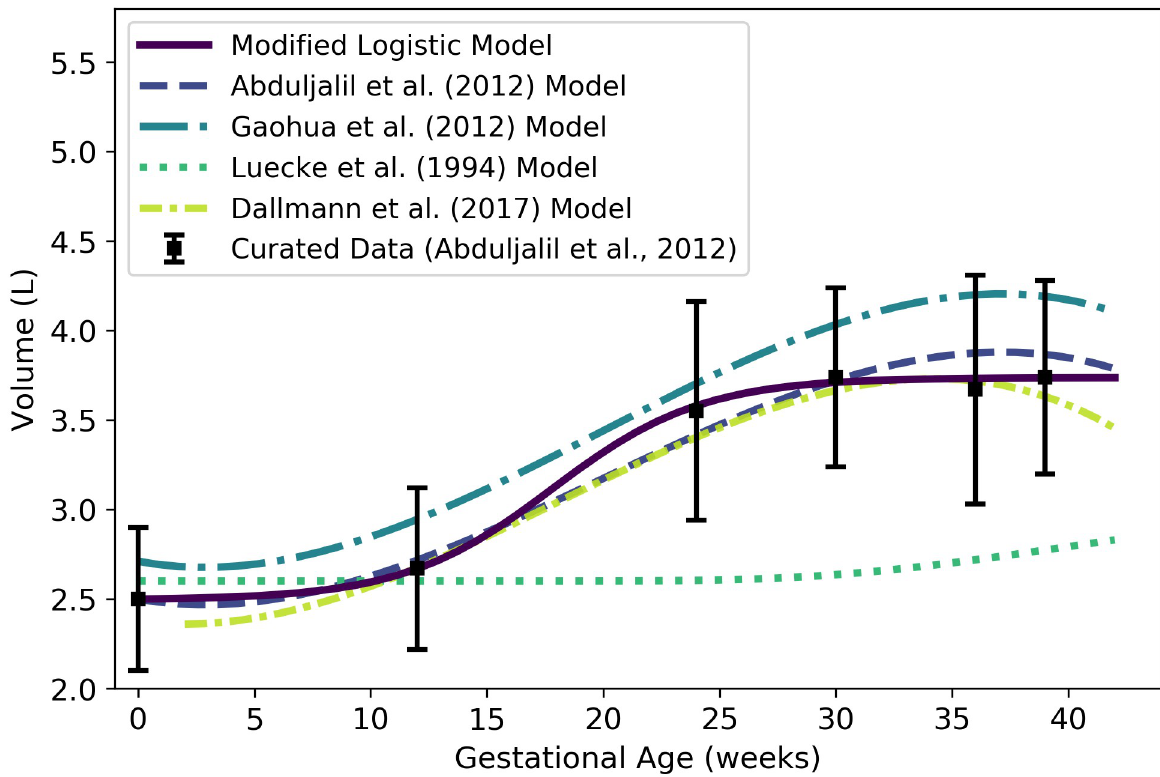
Fig 4. Maternal plasma volume vs. gestational age. The modified logistic model (solid line) given by Eq 5 was selected as the most parsimonious model in our analysis. The models of Abduljalil et al. [28] and Gaohua et al. [29], both cubic polynomials, were calibrated using the same curated data set [28] used by us. The model of Luecke et al. [15] was calibrated using different data. It assumes an initial maternal plasma volume of 2.6 L (or an initial plasma mass of 2.6 kg) and predicts an increase in maternal plasma volume (or mass) as a function of total fetal mass. Dallmann et al. [3] calibrated their cubic model with different